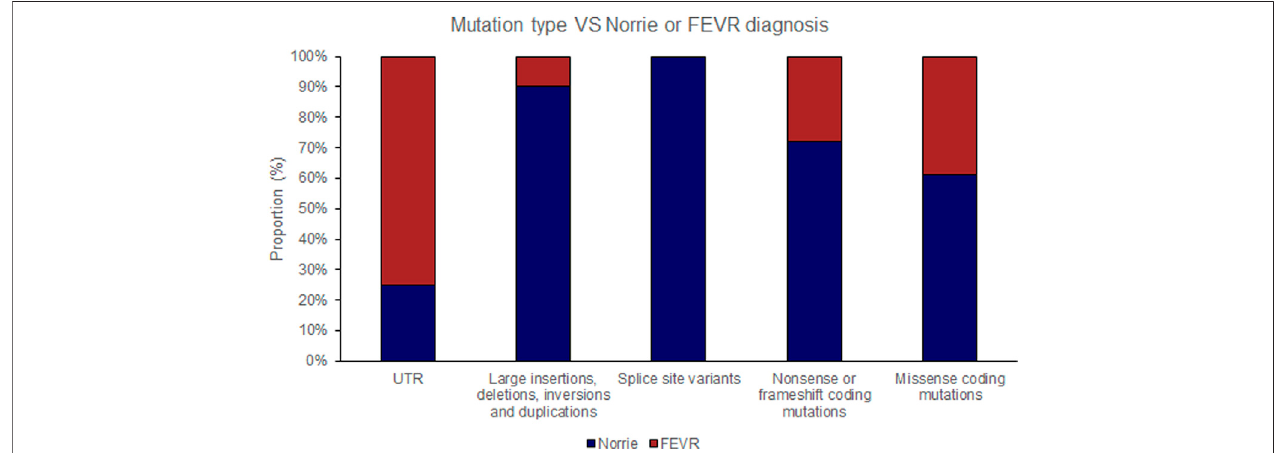
FIGURE 3 | Pathogenic variants ( ‘ mutations ’ ) were classi fi ed by type (UTR [untranslated region], large insertions, deletions, inversions and duplications, splice site variants, nonsense orframeshiftcodingmutationsandmissensecodingmutations).Theproportion ofmutationsofeach typethatcauseseitherNorriedisease orFEVR, as labelled by the authors of each case report, is